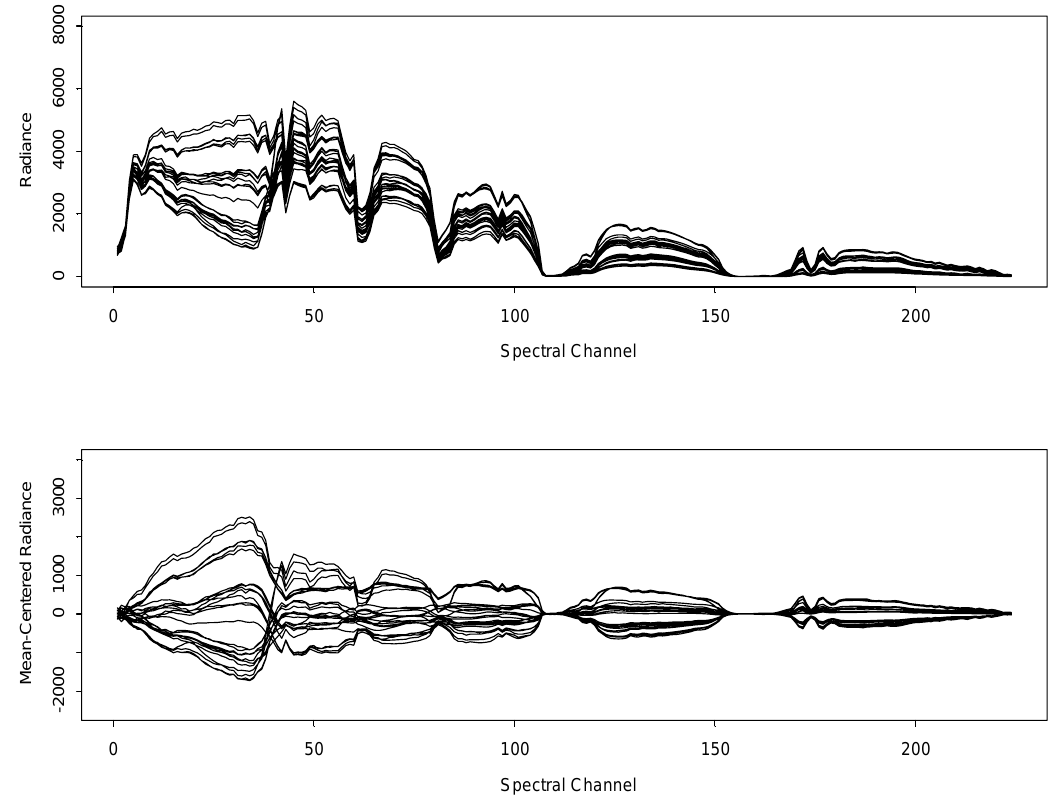
Figure 3 . Example radiance (top) and mean-centered radiance (bottom) from selected pixels in scene